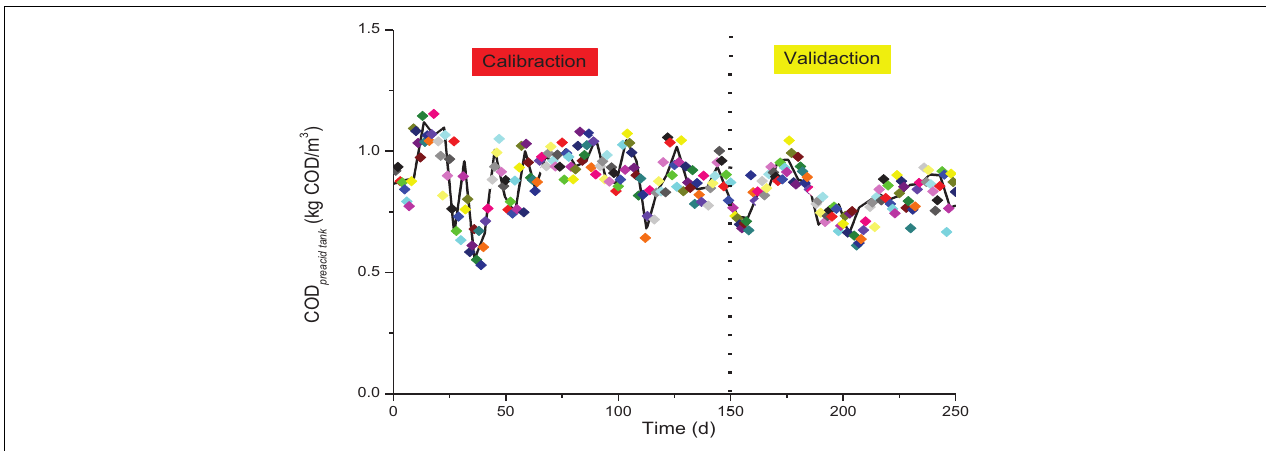
FIGURE 5 | COD eff simulation curve and actual measured value of the effluent from the pre-acidification tank. Calibration part was in 150-days parameter estimation period, and validation part was in subsequent 100-days validation